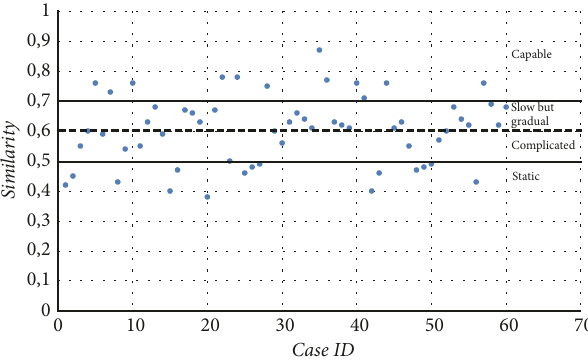
Figure 7: The profiling of Muoviti! app users according to the CREPERIE platform. Similarity values are on Y axis, while case element IDs are on the X